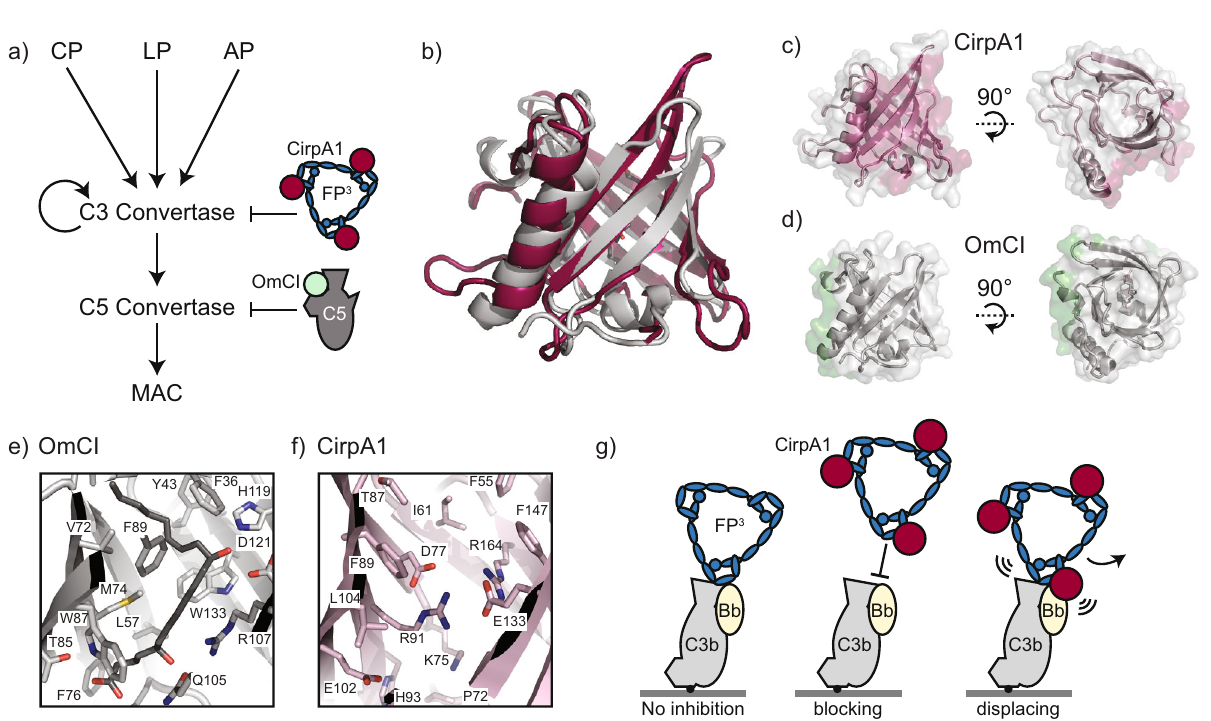
Fig. 5 Broader context of CirpA1-mediated complement inhibition. a Schematic representation of the complement cascade indicating the point of inhibition of CirpA1 (dark red) in comparison to OmCI (light green). b Overlay of structural models of CirpA1 (dark red) and OmCI (grey). c Side and top views of the CirpA1 structure, regions on the CirpA1 surface representation involved in FP Δ 2,3 binding are highlighted in red. d Side and top views of the OmCI structure, regions on the OmCI surface representation involved in C5 binding are highlighted in green. e Close-up of the OmCI ligand binding pocket, bound to leukotriene B4 (PDB 3zuo). f CirpA1 region corresponding to the OmCI pocket shown in ( e ). g Cartoon representation of the proposed mechanism of CirpA1-mediated complement inhibition via blocking of properdin binding (centre) or displacing pre-bound properdin (right) in contrast to undisturbed convertase binding in absence of CirpA1